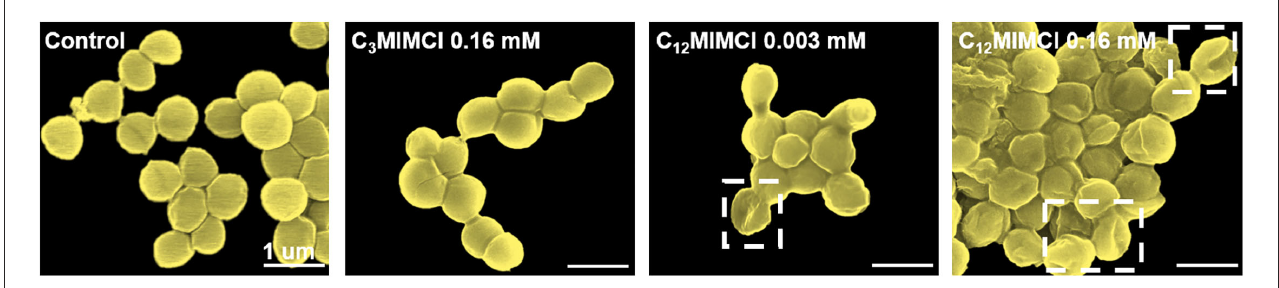
FIGURE4 SEM characterization of Staphylococcus aureus morphologies and membrane integrities after 3h co-culture with water (control group), 0.16mM C